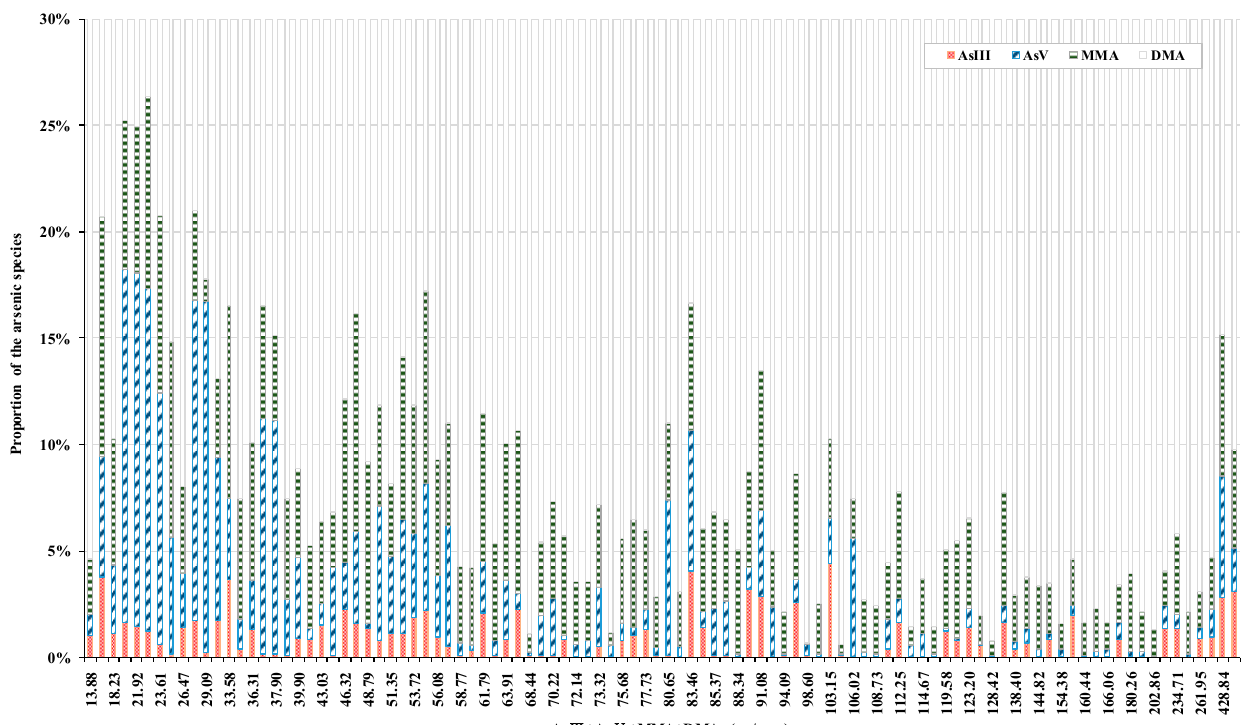
Figure 3. Proportion of As species relative to the sum of concentrations of four As species in 102 abandoned metal mines. Estimation of proportion of cAs using the simple nonlinear model (proportion of AsIII (%)) = 2.724 × (1/(hAs 0.529 )), R 2 = 0.104; (proportion of AsV (%)) = 0.0000998 × hAs 2 − 0.000603 × hAs + 7.114, adjusted R 2 = 0.273; (proportion of MMA (%)) = 0.0000645 × hAs 2 − 0.0381 × hAs + 6.773, adjusted R 2 = 0.306; (proportion of DMA (%)) = − 0.000184 × hAs 2 + 0.106 × hAs + 84.716, adjusted R 2 = 0.318. Goodness-of-fit between cAs estimated by projecting hAs AAS on the simple nonlinear model and actual observed cAs. Observed AsIII = 0.424 × (estimated AsIII) − 0.109, R 2 = 0.0254; observed AsV = − 0.485 × (estimated AsV) + 2.413, R 2 = 0.0233; observed MMA = 1.085 × (estimated MMA) − 0.00760, R 2 = 0.0432; observed DMA = 1.121 × (estimated DMA) − 7.165, R 2 = 0.843.